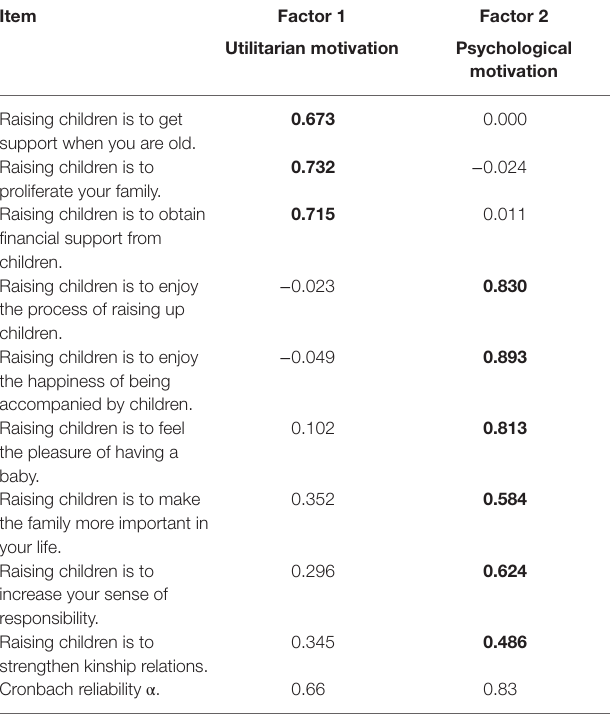
TABLE 2 | Factor loadings for the nine items of childbearing motivation in Study 1.